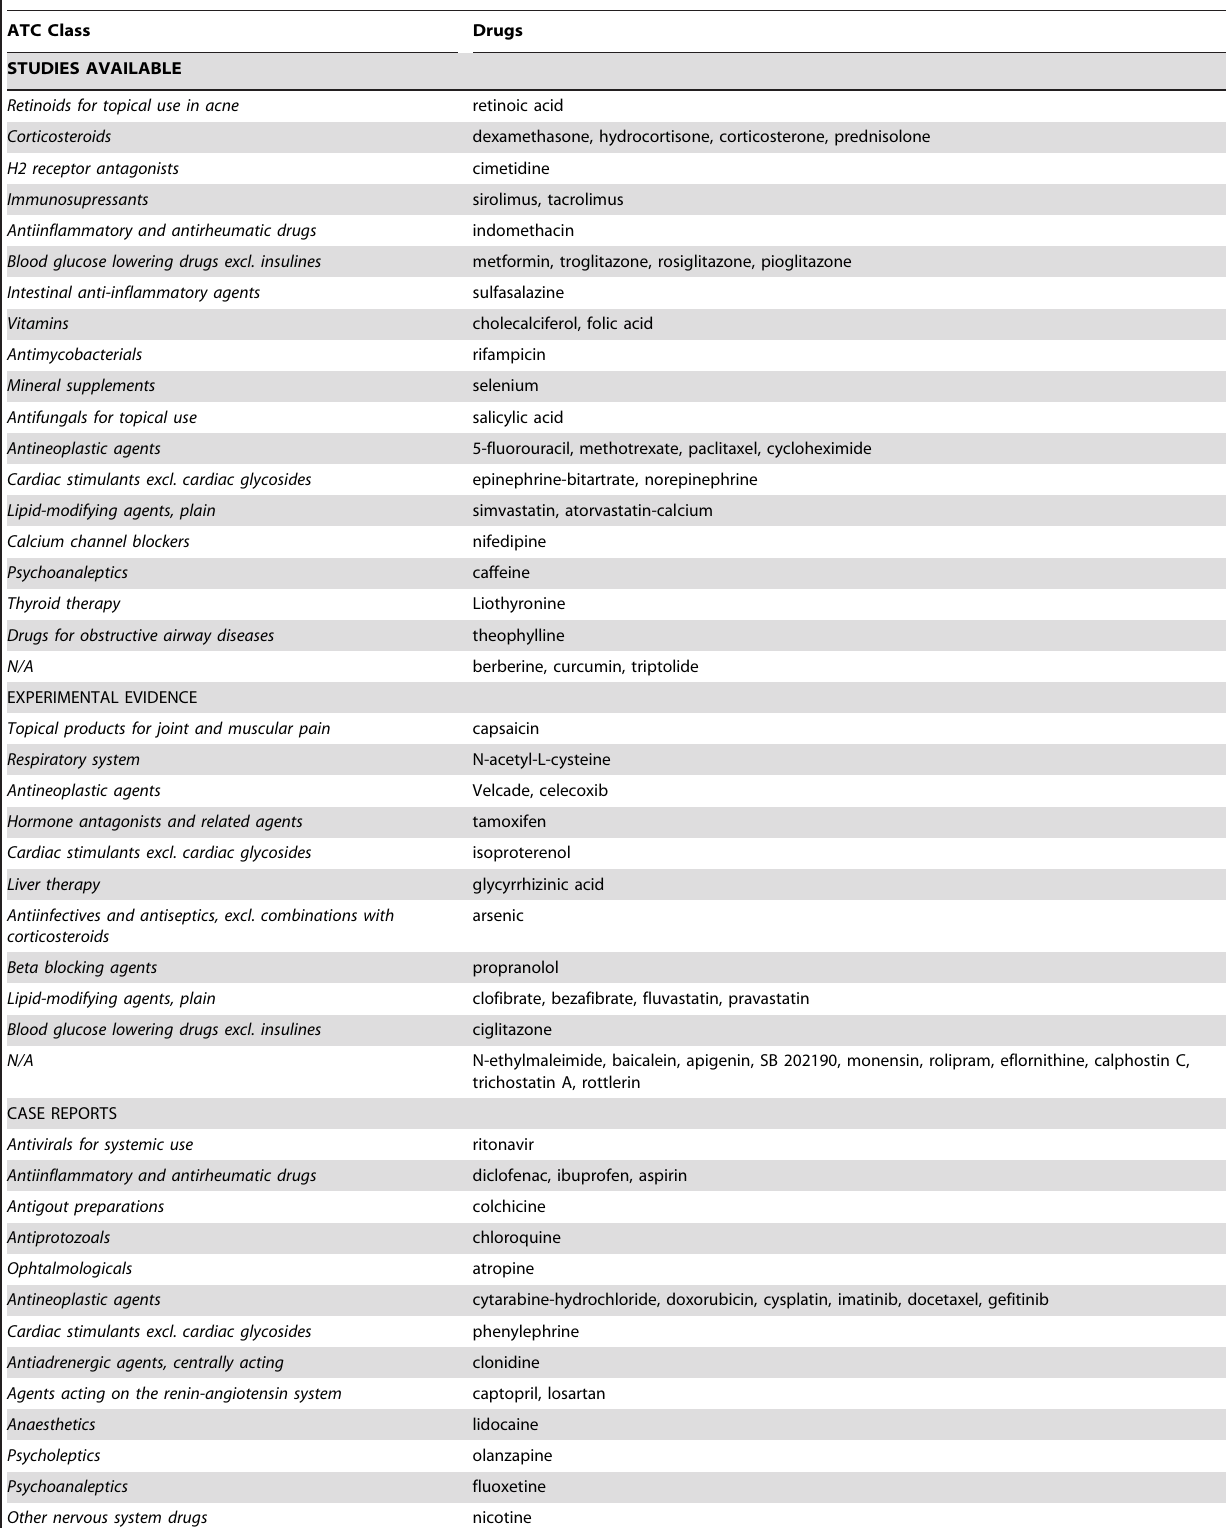
Table 7. Published